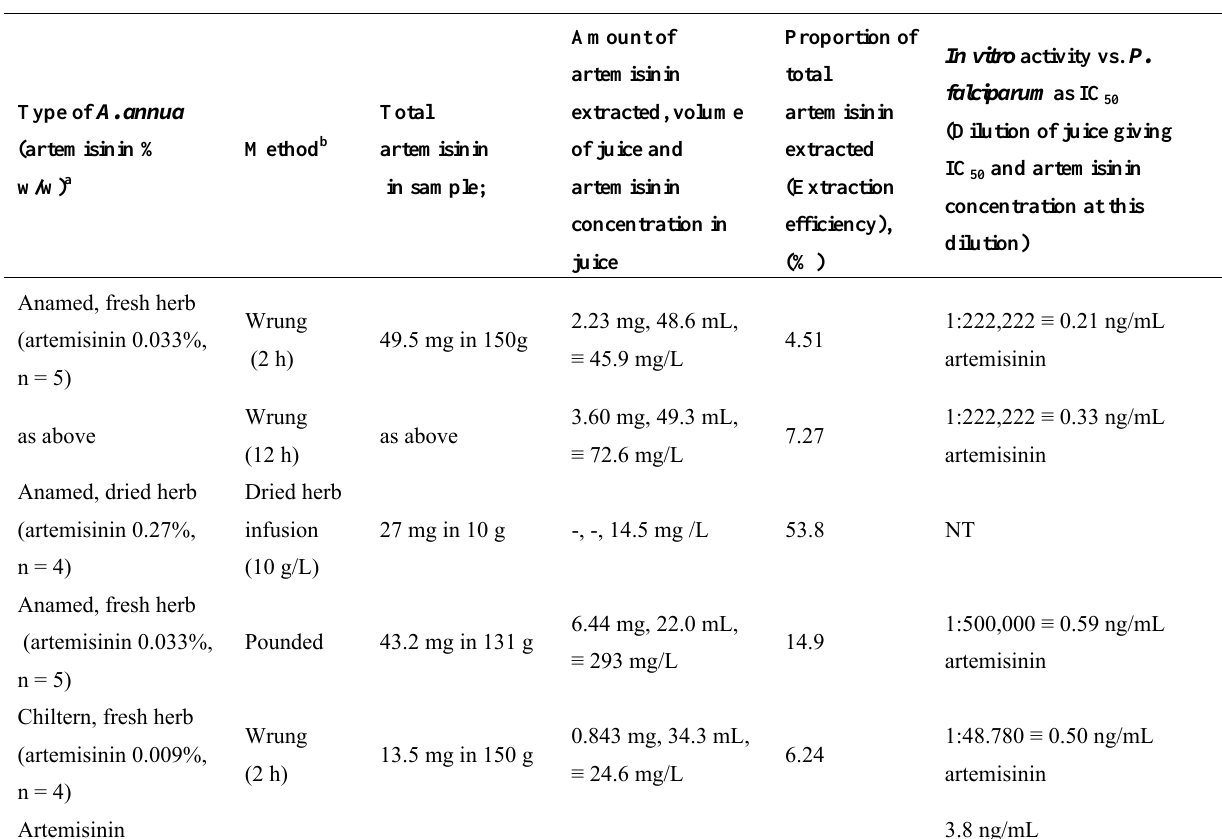
Table 1. Artemisinin content, efficiency of artemisinin extraction and in vitro antiplasmodial activities of preparations made from A. annua herb grown from Anamed (high artemisinin) and Chiltern (low artemisinin) seeds.